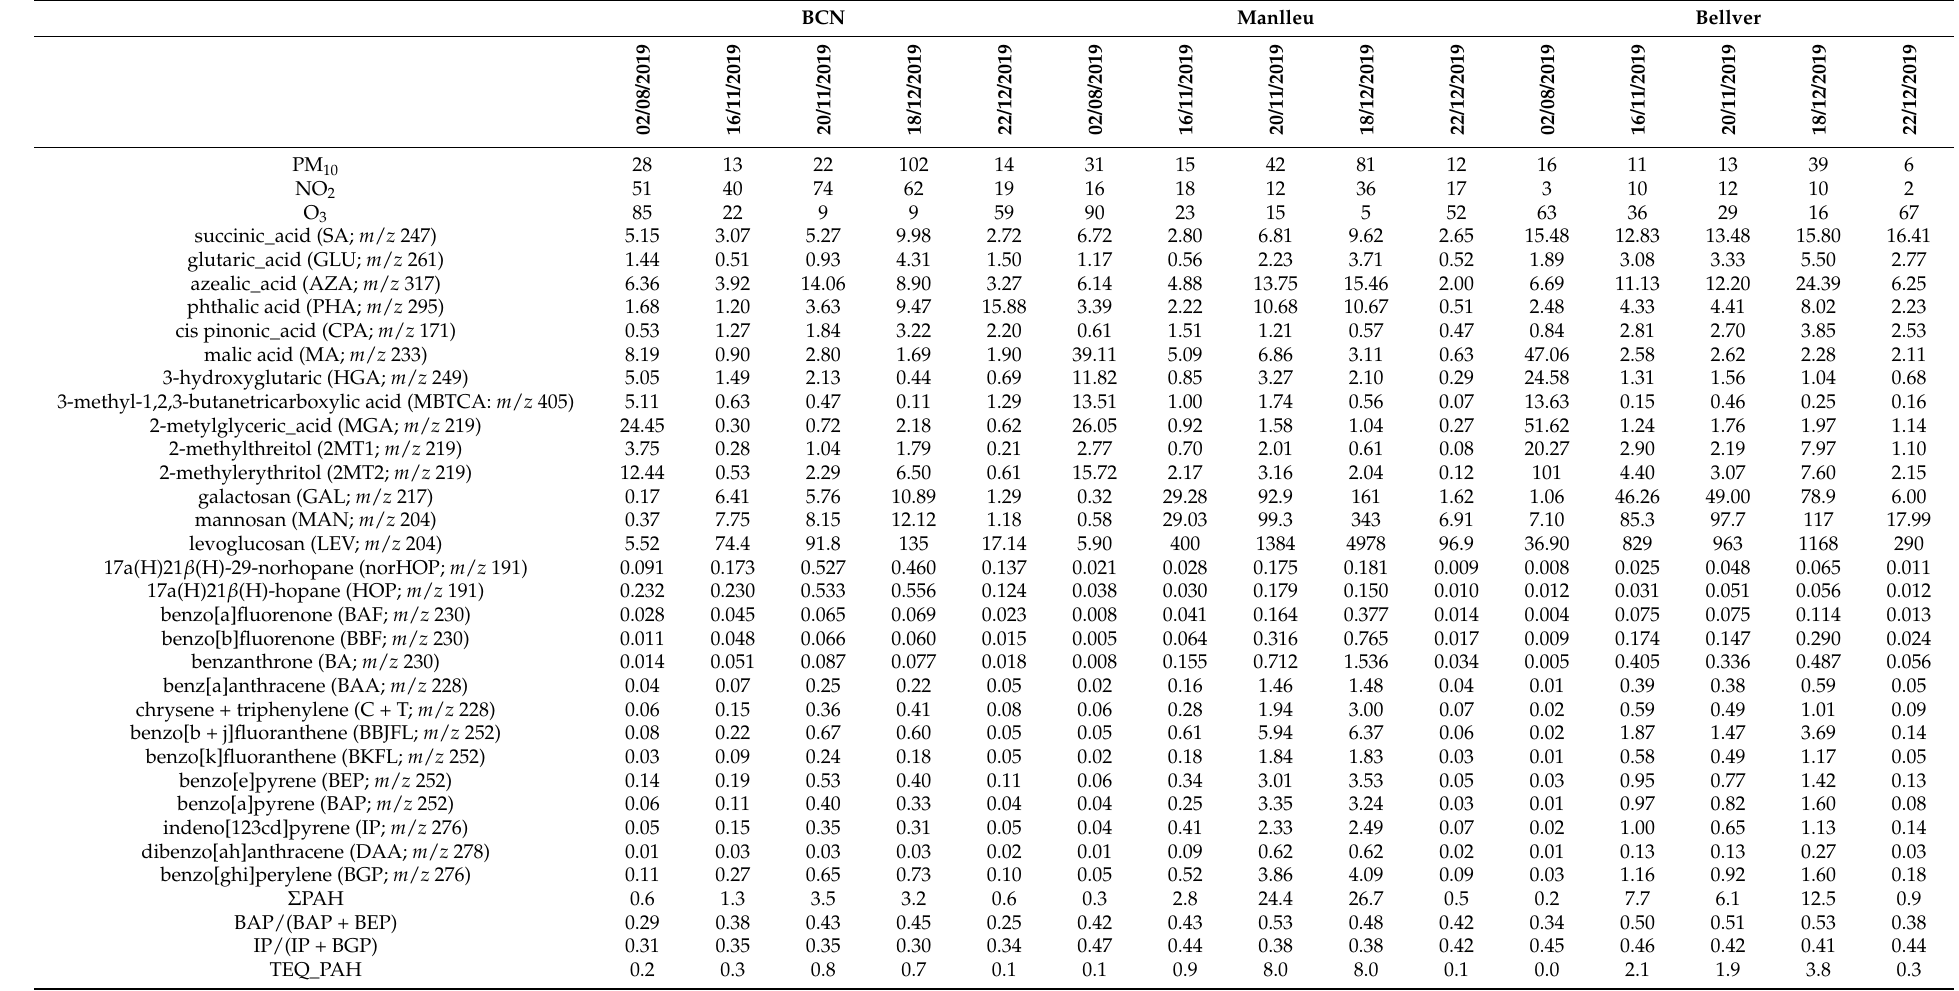
Table 2. Concentration of PM 10 , NO 2 , and O 3 in µ g/m 3 and the analyzed organic compounds for all samples in ng/m 3